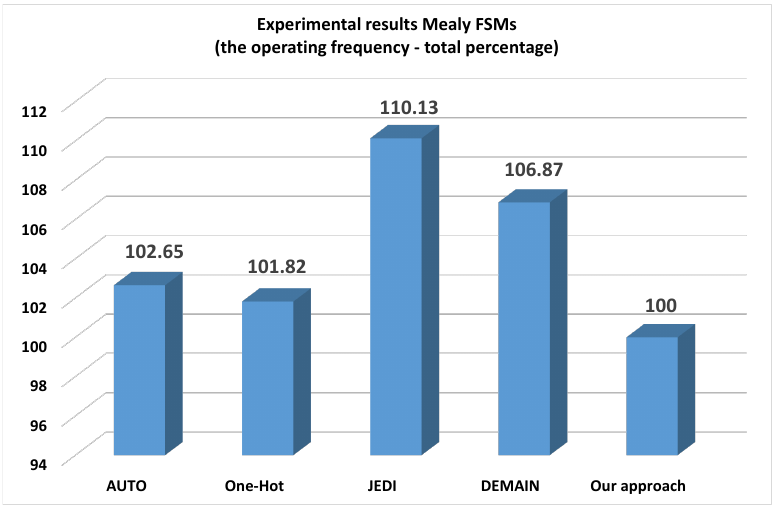
Figure 7. Experimental results (the number of LUTs—total percentage).